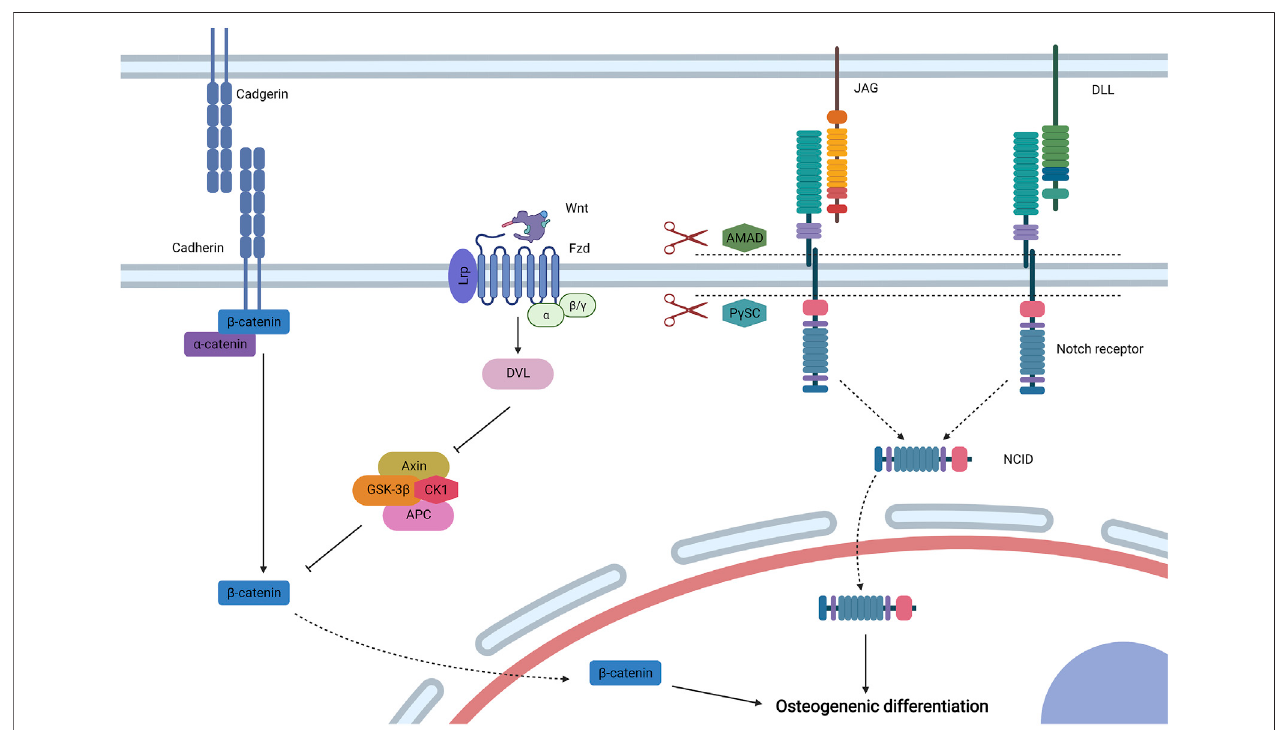
FIGURE 5 | Cell – cell biophysical transduction for MSC osteogenesis: direct interaction. Cadherin is a main molecule to induce direct intercellular interaction, and α -catenin and β -catenin are linked to the cytoplasmic section of cadherin. Under biophysical stimuli, β -catenin dissociates from cadherin to cytoplasm. In addition, β -cateninismainlyregulatedbybiophysicalsensitivecanonicalWntsignaling.Wntbindstothelipoproteinreceptor-relatedprotein(Lrp)/FzdcomplexandactivatesDvlto inhibit the axin/adenomatous polyposis coli/GSK-3 β /CK1 (Axin/APC/GSK-3 β /CK1) complex to avoid the degradation of β -catenin. Then, β -catenin moves to the nucleus to promote MSC osteogenesis. The osteoinduction of direct cell – cell biophysical transduction can be induced by Notch signaling, which is mediated by Notch receptors and Delta-like (Dll) or Jagged (JAG) ligands. Under biophysical stimuli, two proteases, including ADAM-family metalloproteases and presenilin- γ -secretase complex (P γ SC), release Notch intracellular domain (NICD) form Notch receptor, which then moves to the nucleus for osteogenic differentiation. Created with